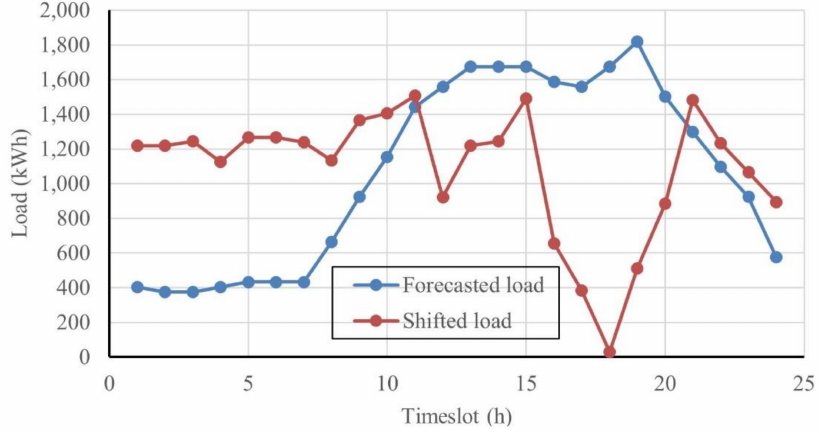
Figure 12. Hourly commercial load before and after DSM using the distributed algorithm RTP-PSO.